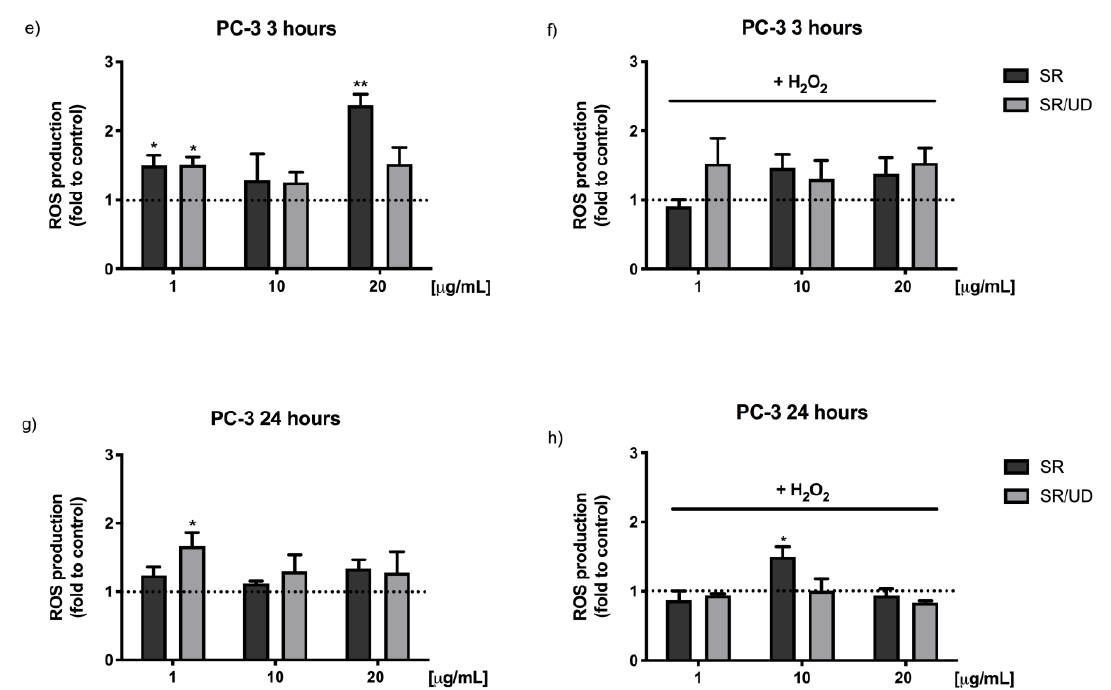
Figure 2. Effect of SR and SR/UD (1, 10, 20 µg/mL) on ROS generation in BPH-1 and PC3 cells. The cells were treated for 3 h ( a , b , e , f ) or for 24 h ( c , d , g , h ) with the two compounds. ROS were detected by DCF-DA staining at the basal condition ( a , c , e , g ) and following the exposure to oxidative stimulus H 2 O 2 ( b , d , f , h ). The fluorescence was measured by using a Victor3X multilabel plate counter (Ex 485 nm and Em 535 nm). Results are expressed as the fold change of ROS production. Each bar represents the mean ± SEM ( n = 3). * p < 0.05, ** p < 0.01, *** p < 0.001, treatment compared to control. The dashed line is the control.